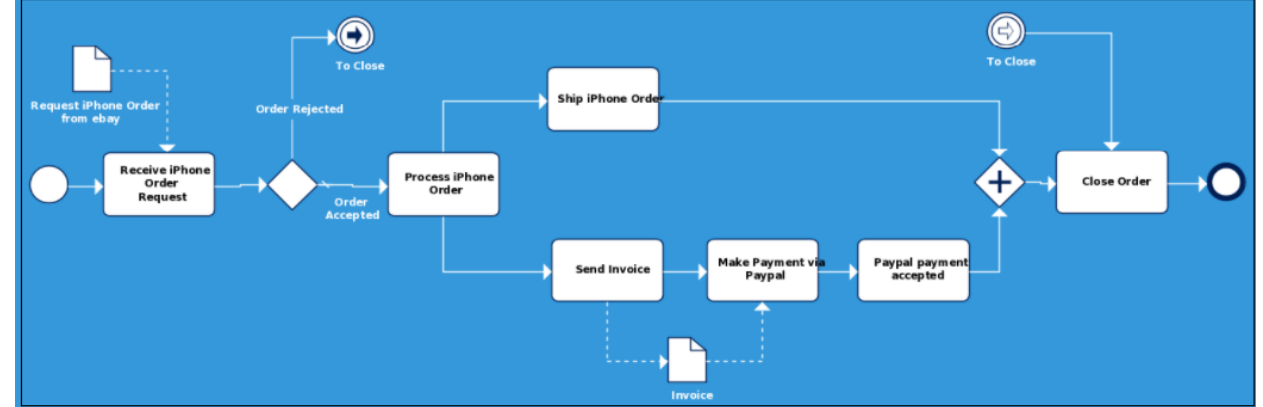
Figure 3. BPMN diagram of iPhone ordering process from eBay.